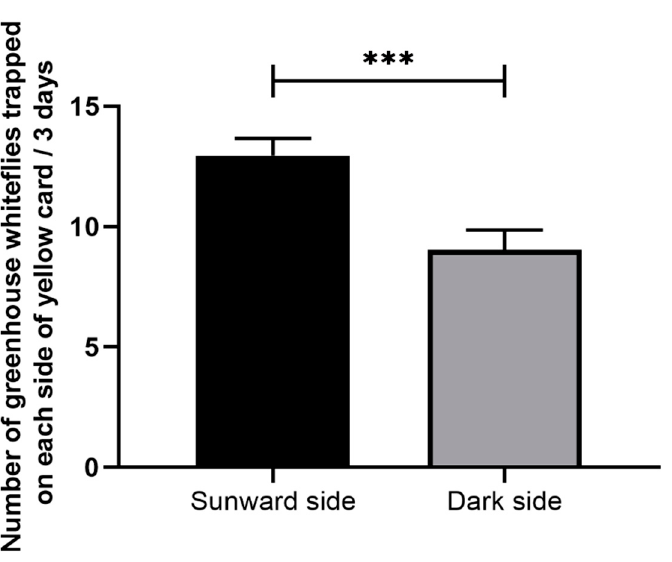
Figure 4. Pairwise comparison of the number of T. vaporariorum trapped on the sunward side and dark side of the yellow sticky card. *** , Significant difference at p < 0.001 by the pairwise t test. Error bars represent the standard error.